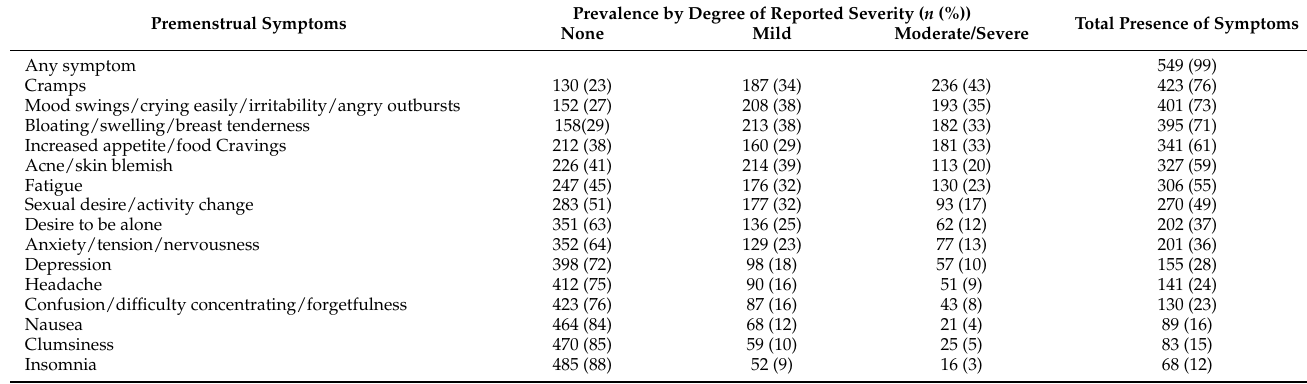
Table 1. Prevalence of reporting of premenstrual symptoms among 553 women. Premenstrual Symptoms Prevalence by Degree of Reported Severity ( n (%)) Total Presence of Symptoms None